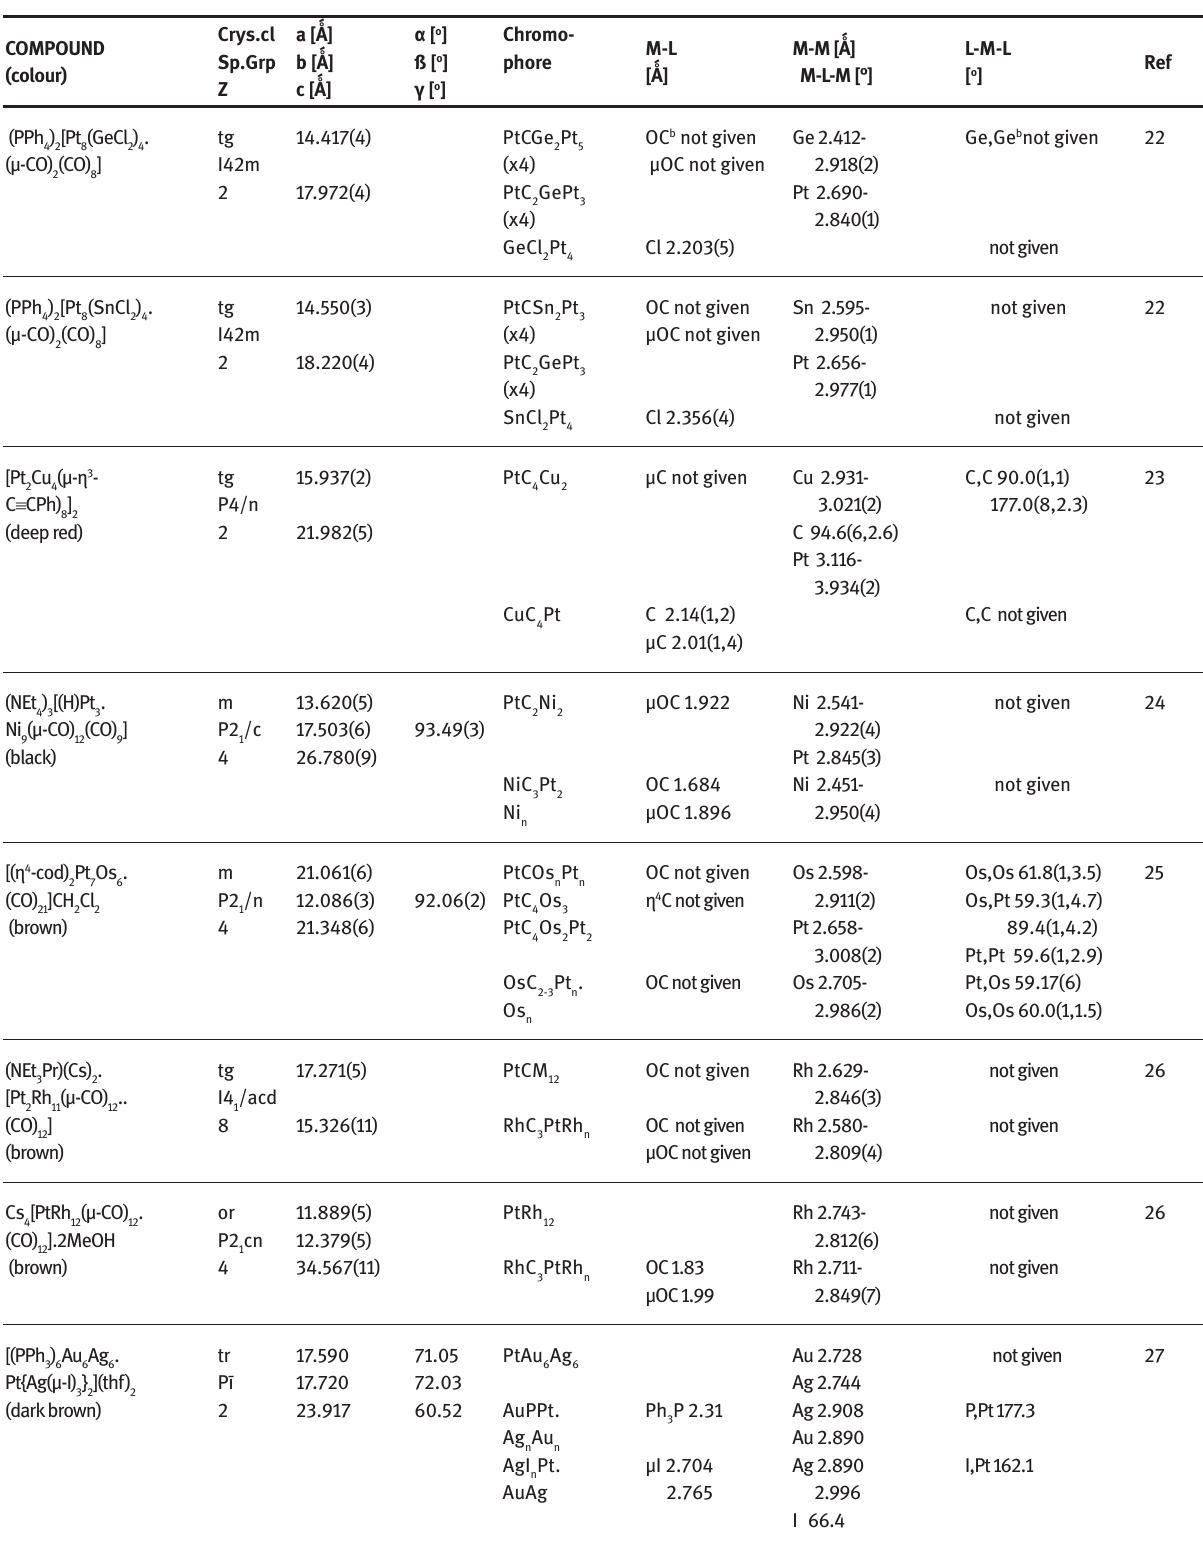
Table 3: Crystallographic and structural data for heterododeca- and heterooligonuclear platinum clusters a .